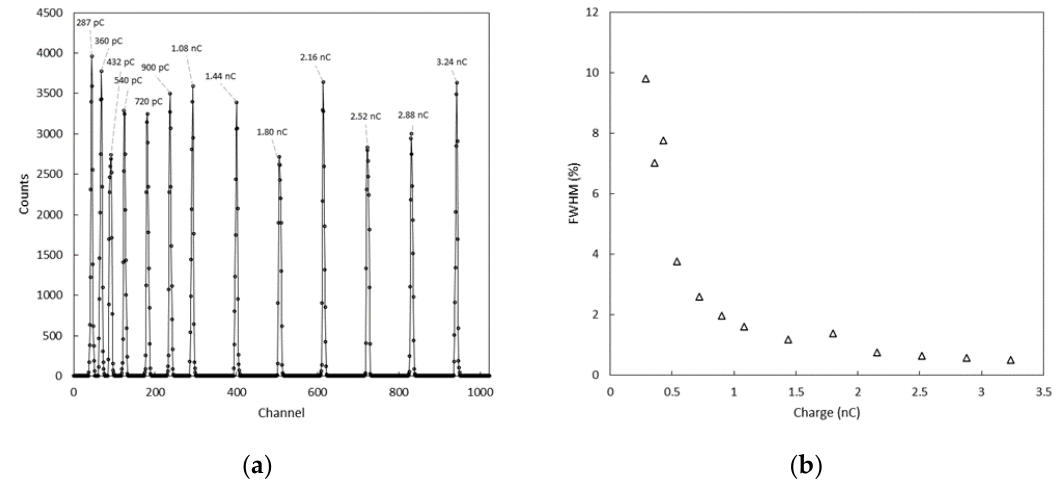
Figure 7. Histogram of the counts used to for the noise test ( a ); charge resolution ( b ).